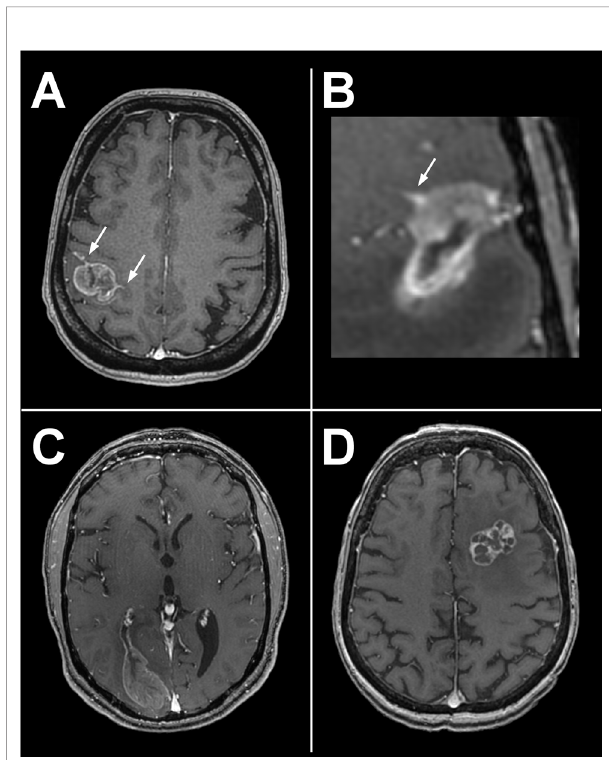
FIGURE 7 | Four incorrectly classi fi ed BM of the test set. Two of them presented tumoral leptomeningitis (arrows, A, B ), one a metastatic ventriculitis (C) and the forth one a multilocular lesion (D) . Leptomeningitis and ventriculitis may have interfered with spatial delineation of tumor